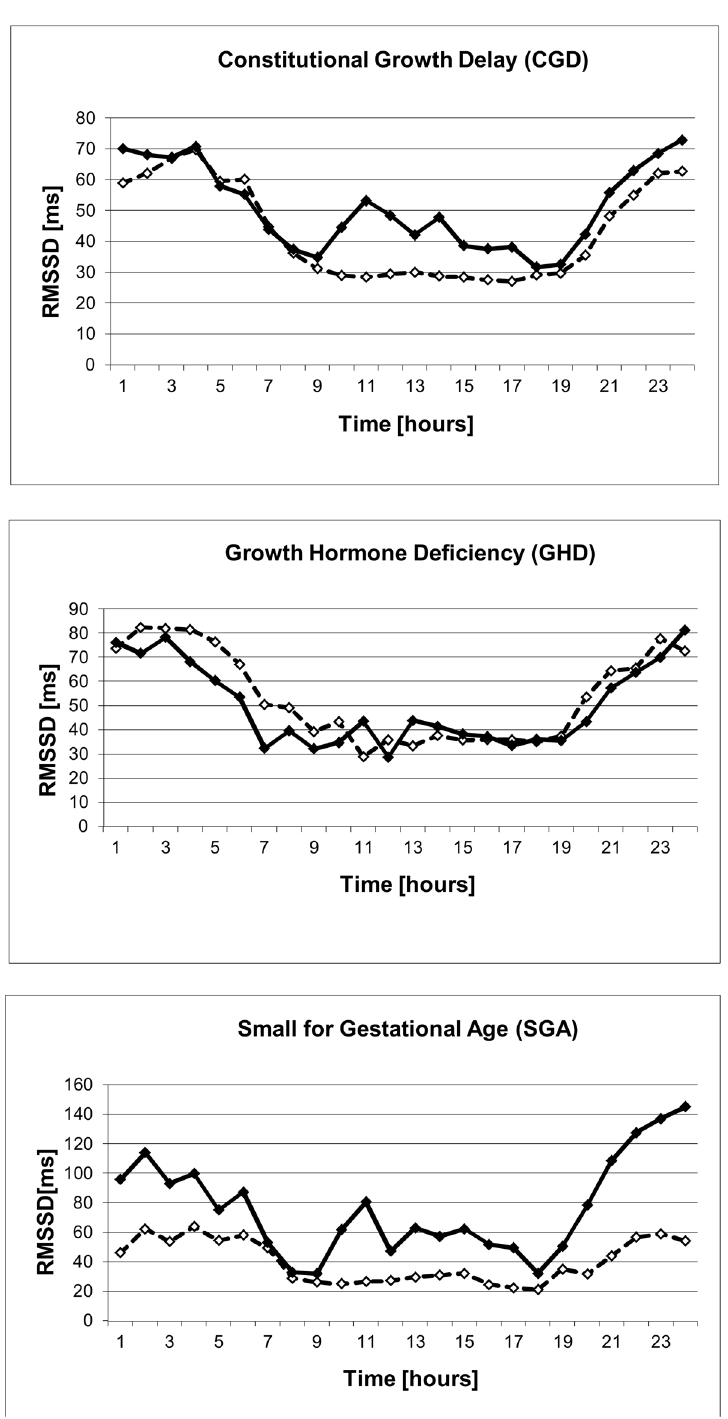
Fig 1. Effect of clonidine on rMSSD in normal and short stature children. Effect of clonidine given at 9:00 a.m. on the vagus parameter rMSSD in children with constitutional growth delay (n = 36) ( ♦ ) compared to baseline data of age-matched healthy controls ( ^ ). Children with growth hormone deficiency (n = 14) and small for gestational age (n = 6) show reduced vagal activation after clonidine administration ( ♦ ).